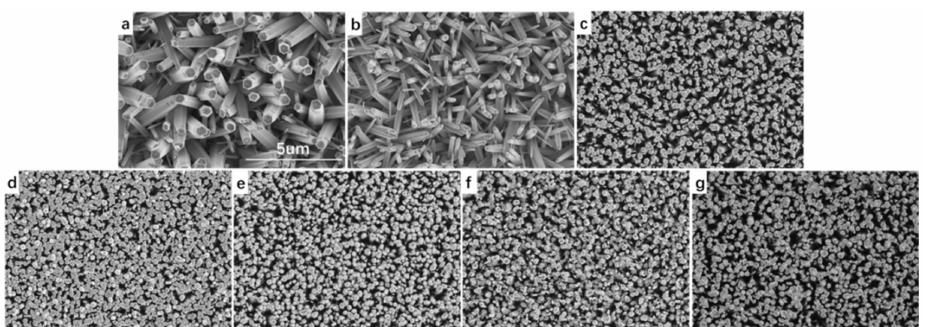
Figure 3. Typical SEM images of ZnO nanoarray based on the seed layer with different ZnAC/PVA volume ratios. ( a ) 0.027:1, ( b ) 0.055:1, ( c ) 0.11:1, ( d ) 0.22:1, ( e ) 0.44:1, ( f ) 0.72:1 and ( g ) 0.87:1. All images use the same scale bar.